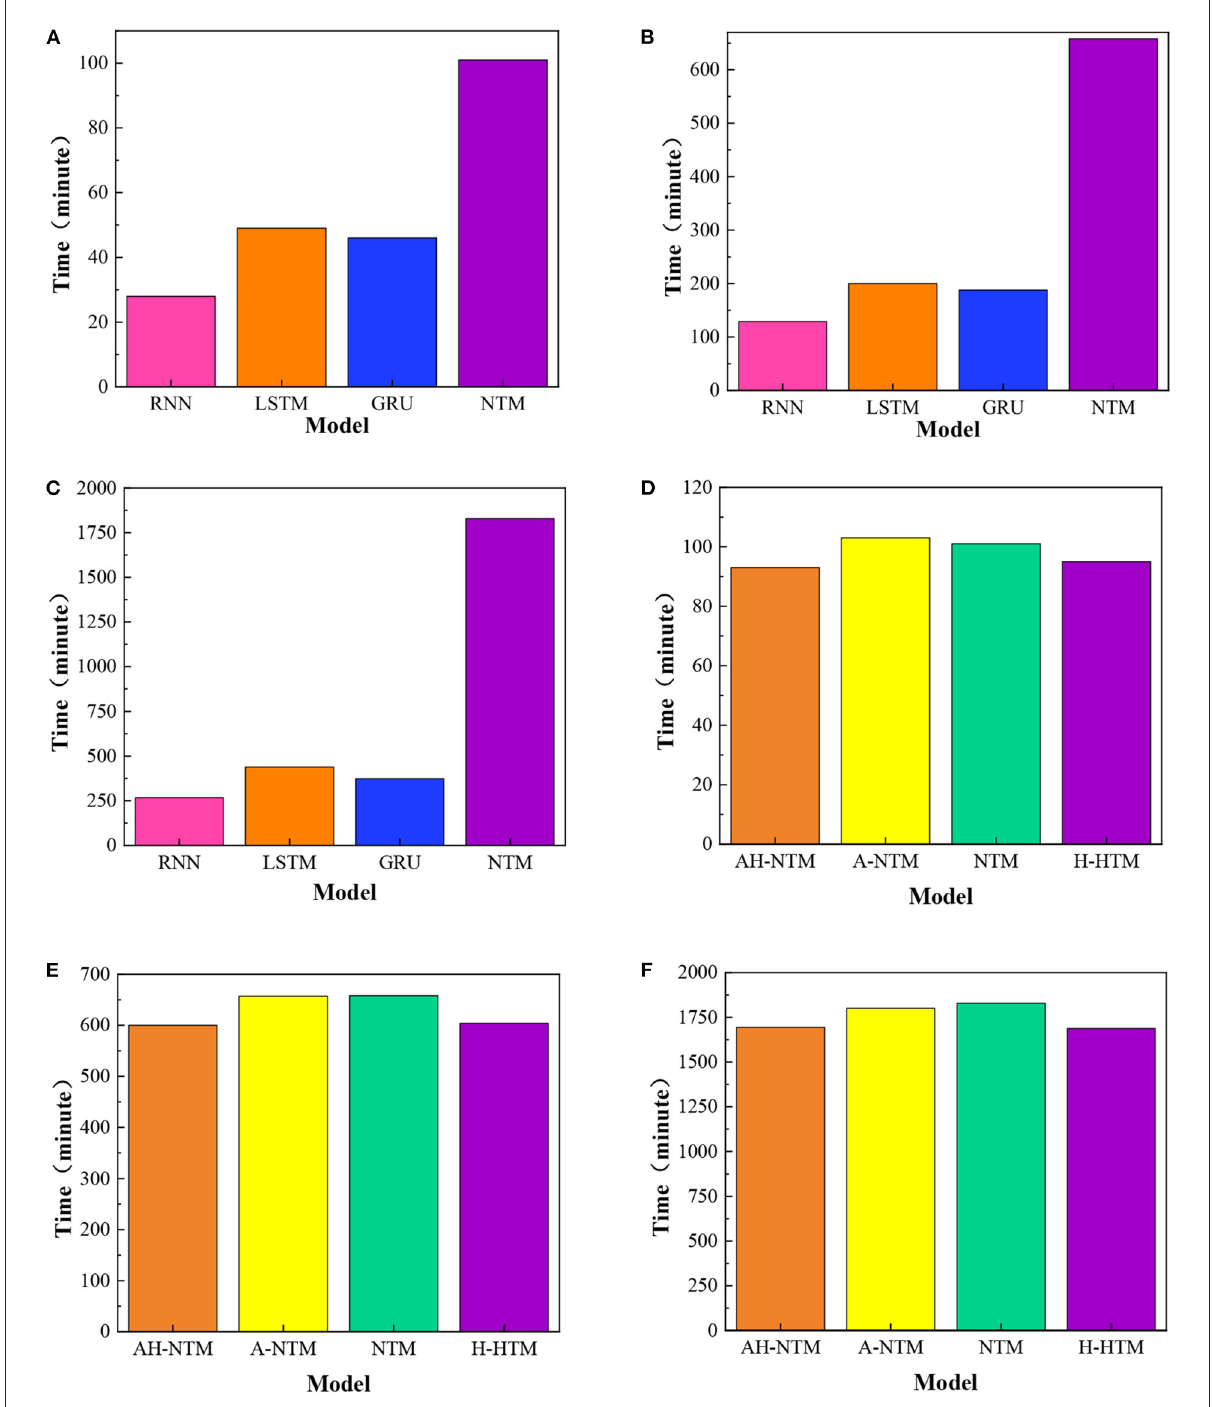
FIGURE1 Comparison of training time of different models, (A) replication; (B) addition; (C) multiplication; (D) replication; (E) addition; (F) multiplication.